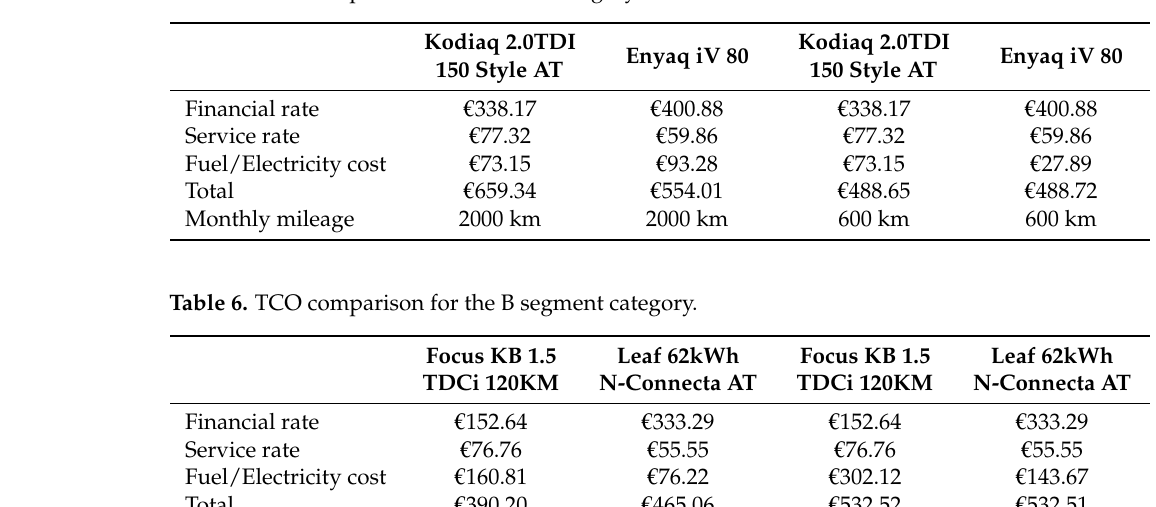
Table 5. TCO comparison for the SUV category.